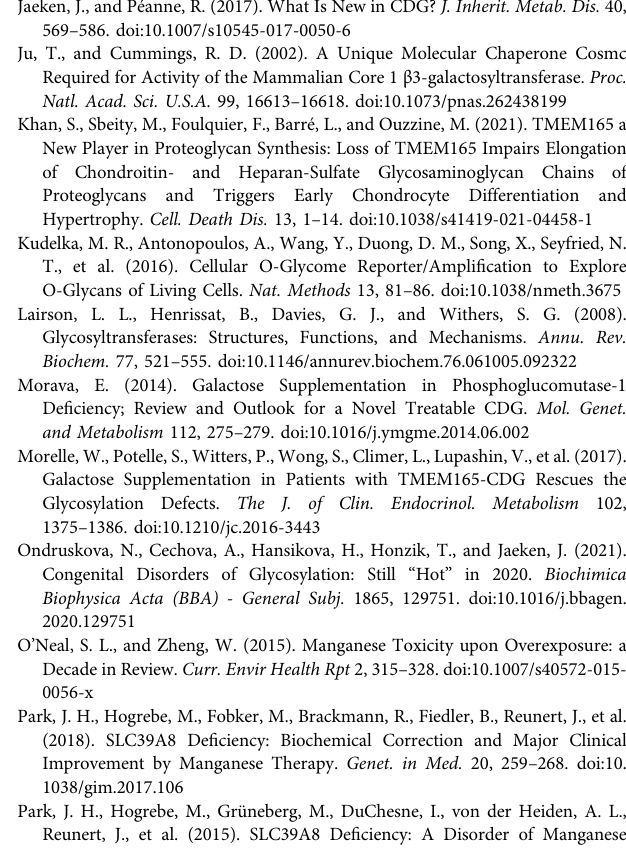
and TMEM165 KO HEK cells. Cells were submitted to the indicated treatments, fi xed and subjected or not to neuraminidase. Cells were stained with PNA-Cy5 (red) before confocal microscopy visualization. For clari fi cation DAPI staining has been omitted ( n = 3; p value < 0,005). Supplementary Figure S2 | Impact of cyclopiazonic acid on the LAMP2 and TGN46 glycosylation pro fi les in HEK cells treated with MnCl2 and/or D-Galactose. Western-blot of LAMP2 in control and TMEM165 KO HEK cells, treated for the indicated times with or without 2.5 μ M MnCl 2 and/or 1 mM D-Gal, in the presence or absence of 100 μ M cyclopiazonic acid, a SERCA pump inhibitor. The electrophoretic migration positions of the fully- and under-glycosylated forms of proteins are indicated on the right side of the western blot ( n =